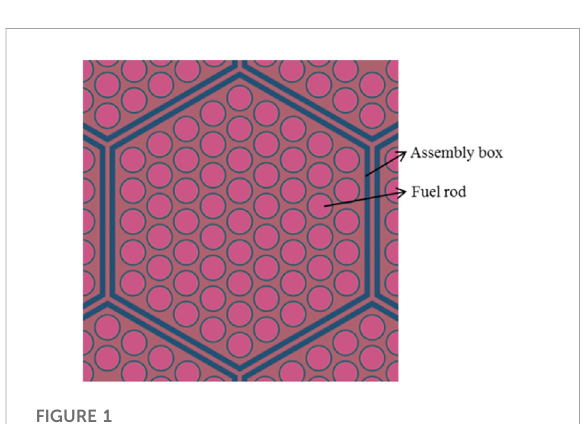
FIGURE 1 Hexagonal assembly geometry of the SLBR-50 reactor (Zhou et al., 2018).